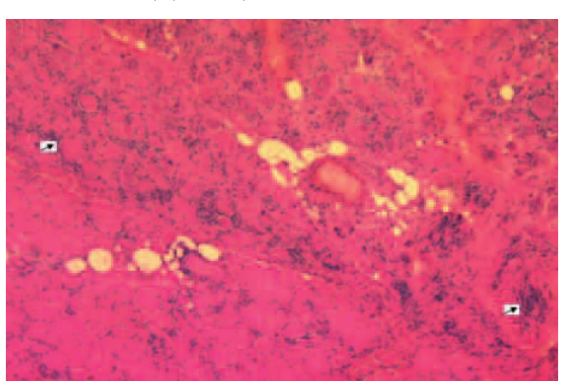
Figure 1. Histological picture of IBM. Increased variation of fi ber size, frequent intracytoplasmic nucleus (black arrow), endomysial fi brosis, fi ber splitting, whorled fi bers (white arrow) and chronic infl ammation can be seen (cutted white arrow). (HE; 100x)